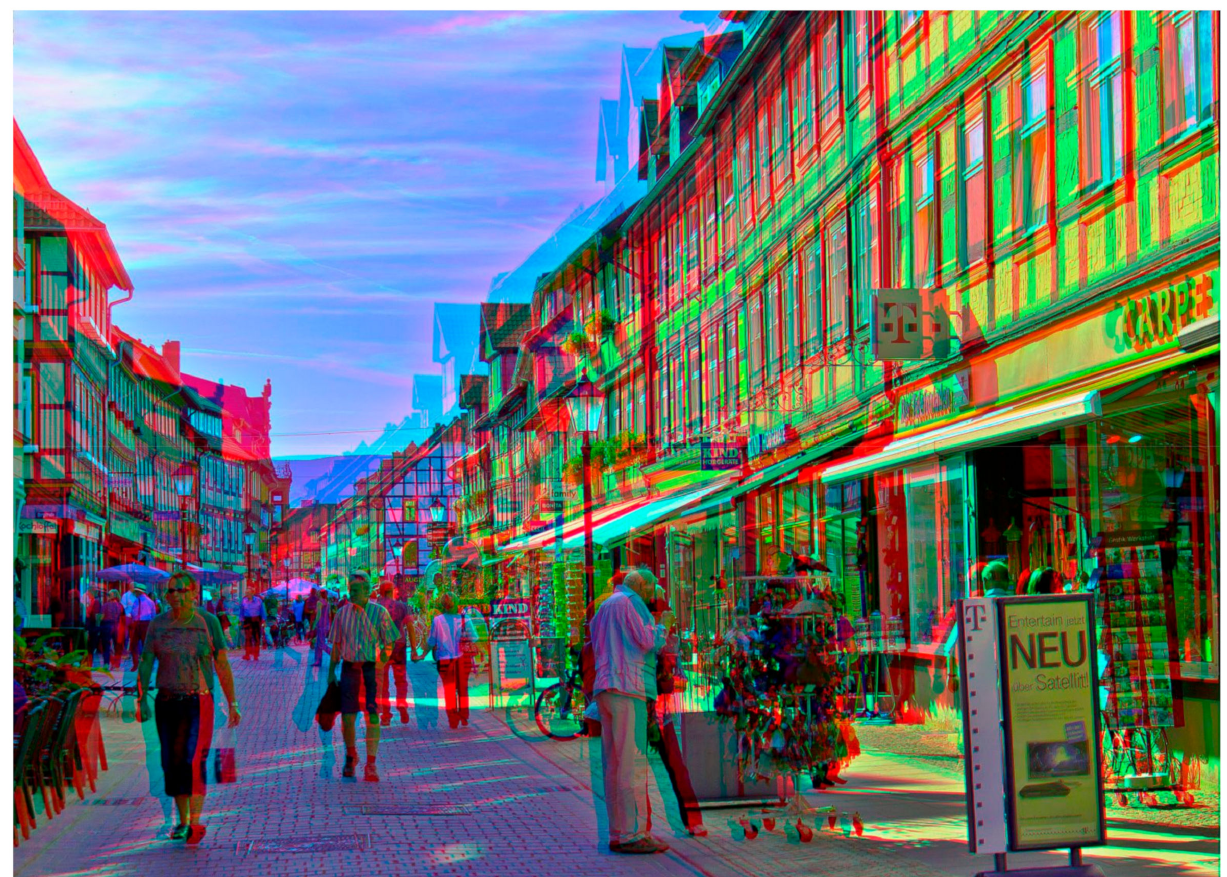
Figure 12. ‘Wernigerode Boulevard’ (2011) by Sascha Becher. © Sascha Becher. Used with permission from: https: //www.flickr.com/photos/stereotron/6597314627/in/album-72157612377392630/ (accessed on 30 September 2020). For more of Sascha Becher’s telestereoscopic images please see: https://www.flickr.com/photos/stereotron/ (accessed on